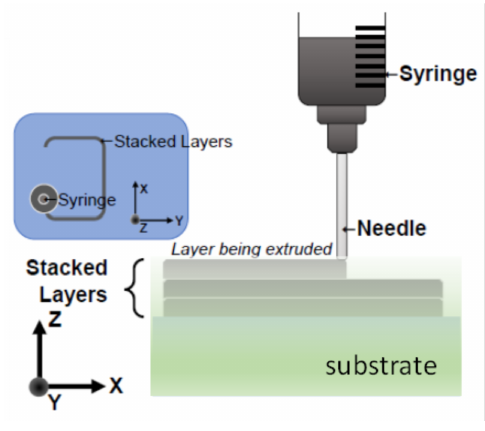
Figure 7. Schematic diagram of antenna 3D printing